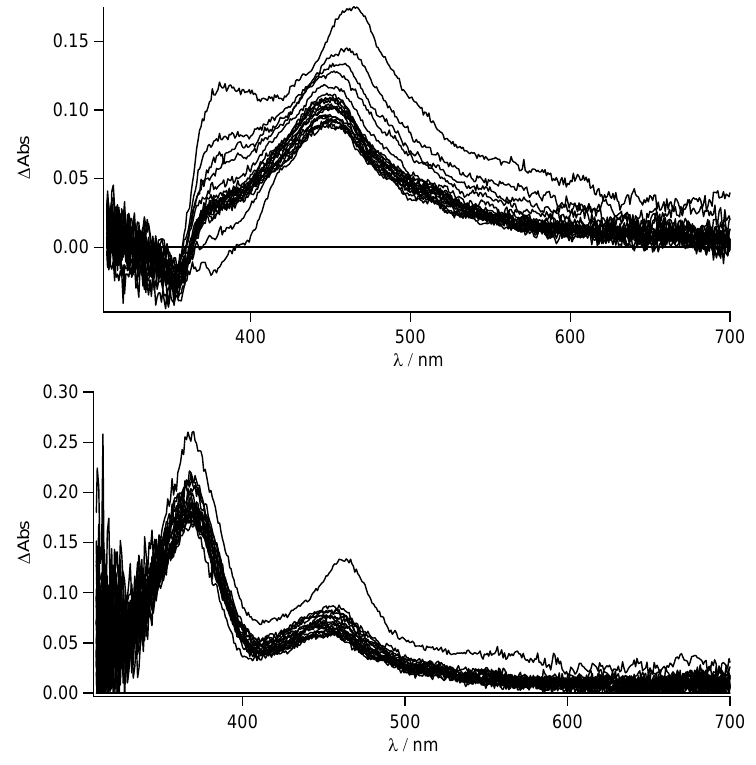
Figure 8. Nanosecond transient absorption spectra of TpyPhPyrene Zn ( TpyPhPyrene ) (bottom) in acetonitrile with 5 ns incremental time delay 2 2 (  = 290 nm). ex